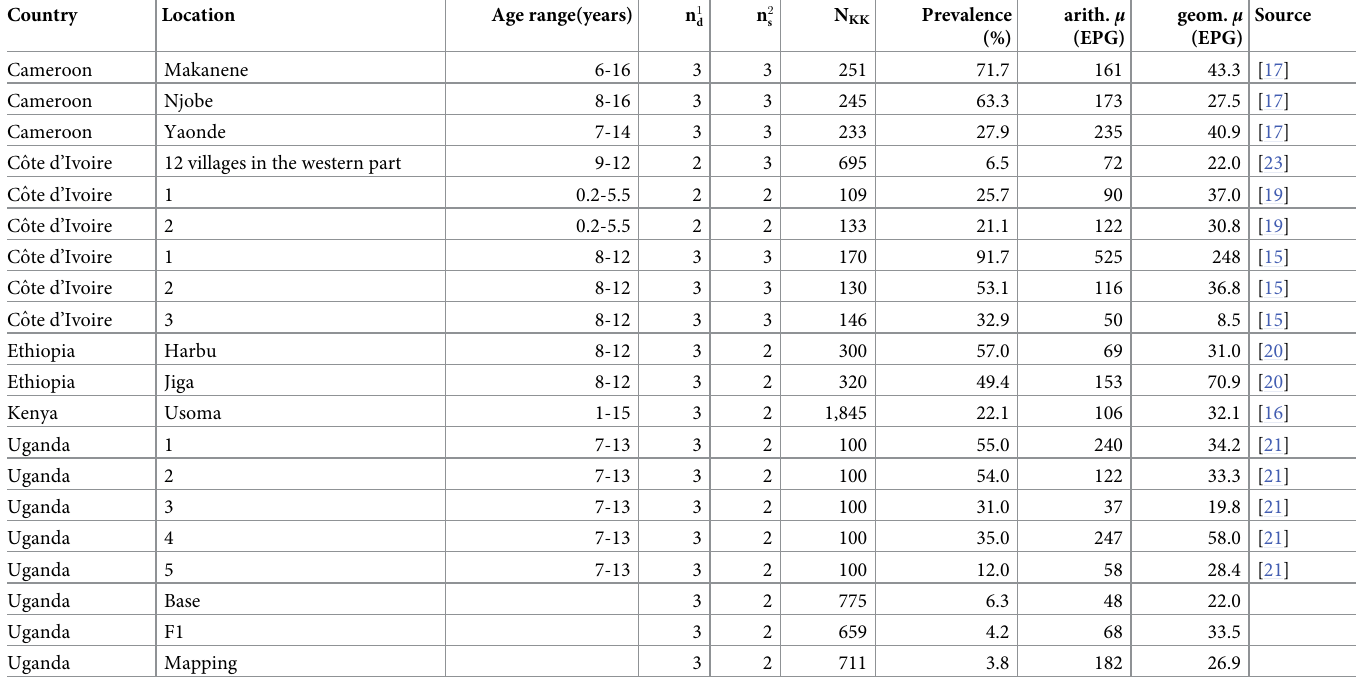
Table 1. Summary of the survey data used to parametrize the current simulation study. Country